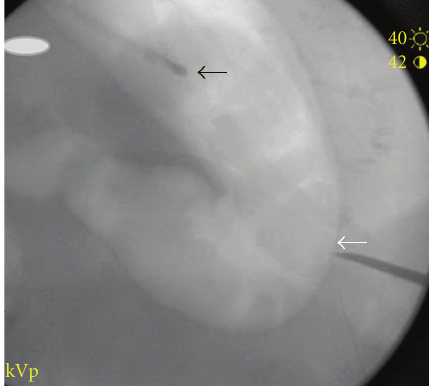
Figure 5: G-tube tip adequately place in stomach (white